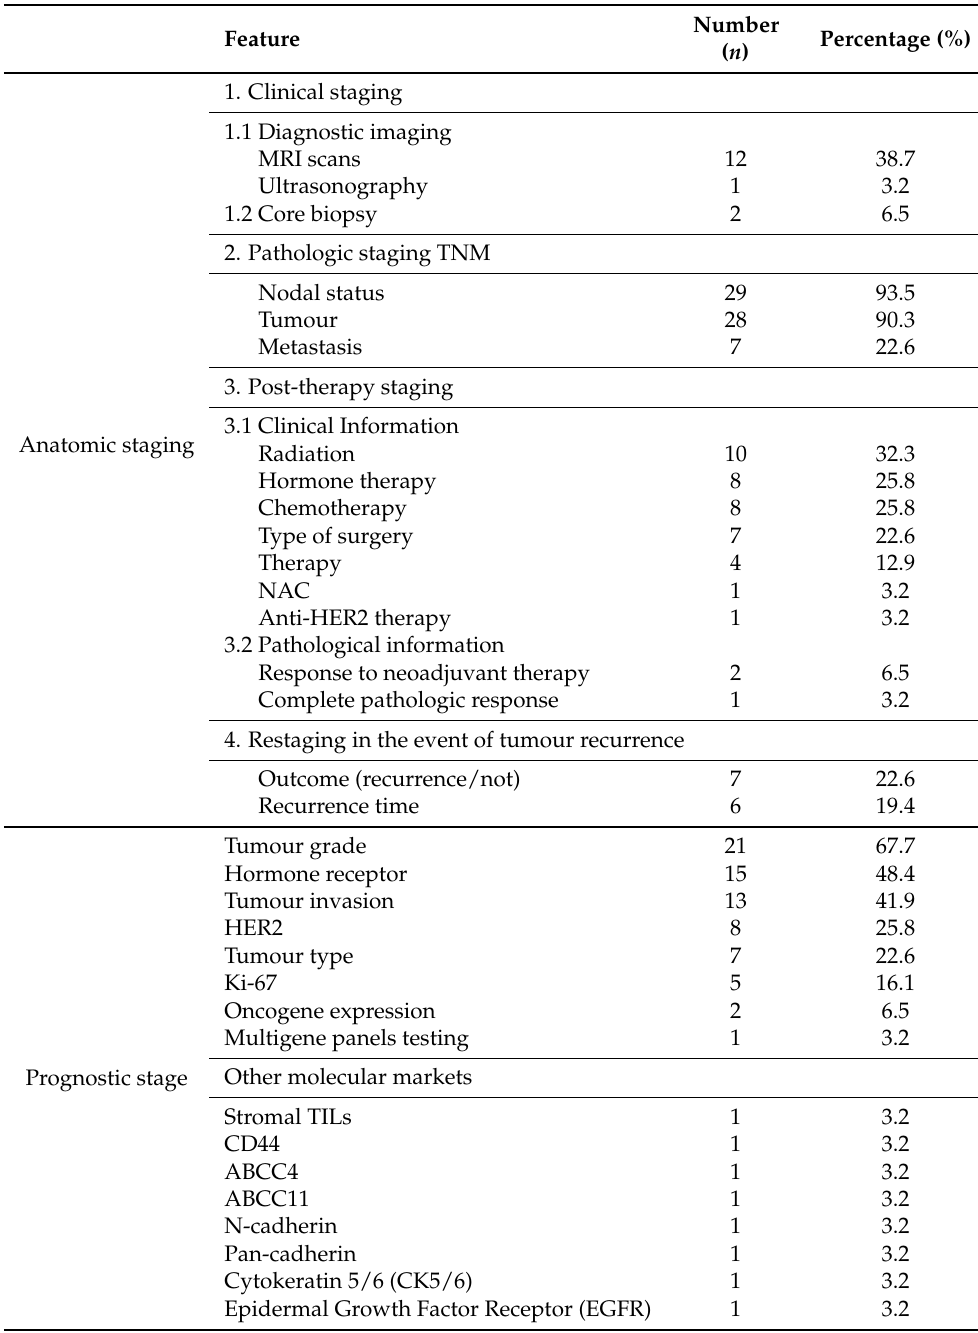
Table 4. Feature predictors used based on clinical and molecular information. n corresponds to the number of studies using each feature; % is n /31 × 100, 31 being the total of studies included in this